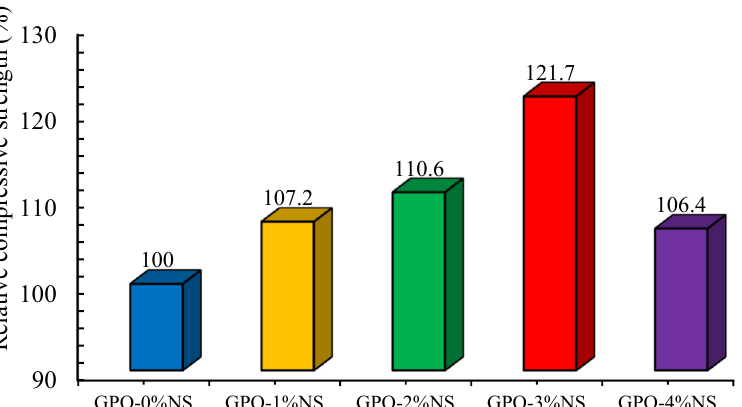
Figure 4. Relative COS of carbon-fiber-reinforced GPO composite pastes with various contents of NS.